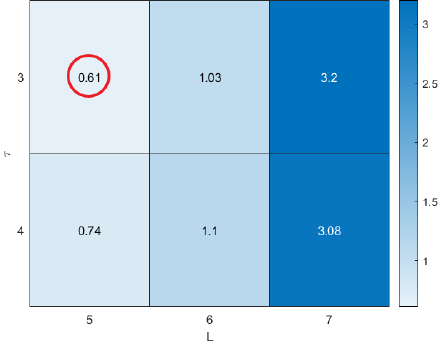
Figure 4. Optimal parameter selection results.